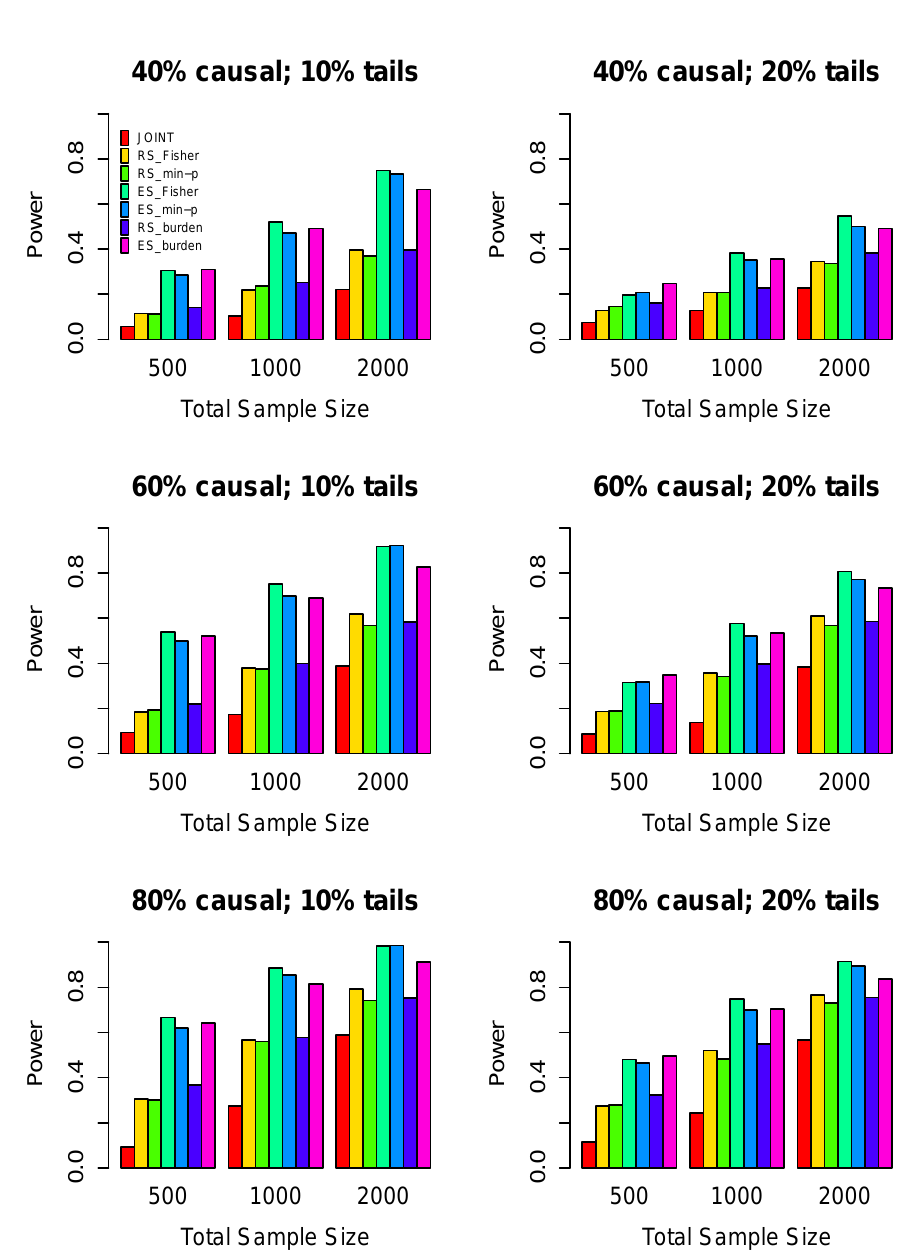
Figure 2. Power comparisons of seven tests when 80% causal variants have a positive effect on phenotype while the remaining 20% have a negative effect. The left panel considers 10% high/low extreme phenotype sampling with the three rows corresponding to 40%, 60%, and 80% causal variants. The right panel considers 20% high/low extreme phenotype sampling. Three sample sizes are considered: n = 500, 1000, 2000. Powers are estimated at the 0.05 significance